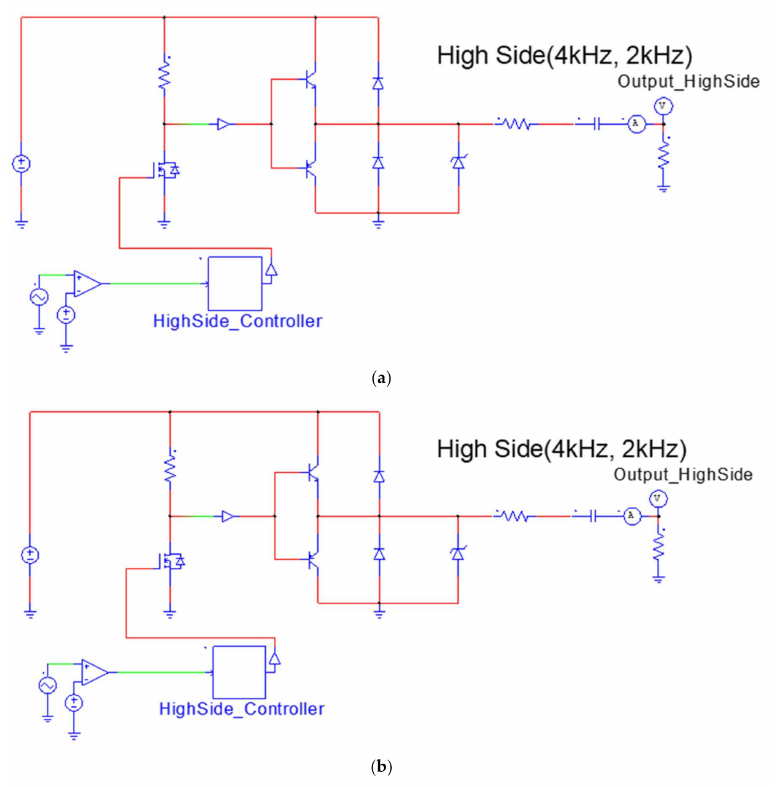
Figure 6. The frequency generating circuit: ( a ) high side circuit in the transmitter; ( b ) low side circuit in the